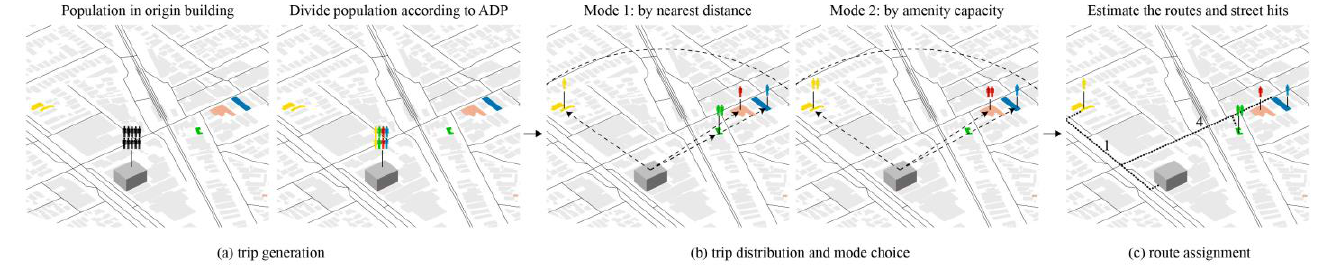
Figure 2. Trip-sending simulation process for each building.